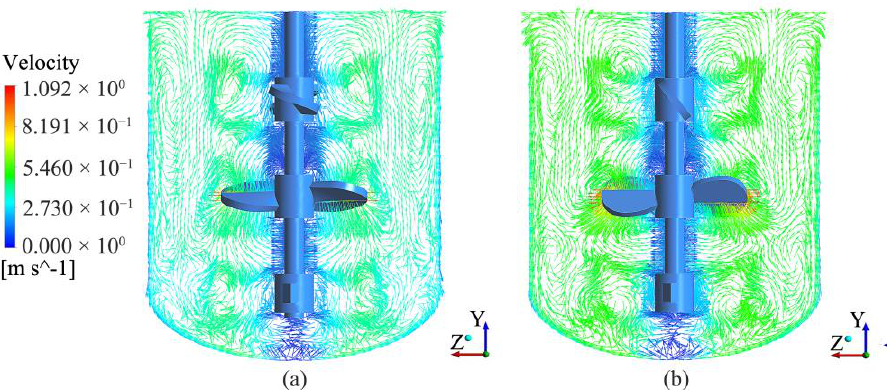
Figure 9. Velocity vector diagram when the medium in YZ section is water and Re = 44,910. ( a ) TBC-A type agitator, Plane 2:YZ,X = 0 mm; ( b ) TBC-B type agitator, Plane 2: YZ,X = 0 mm.